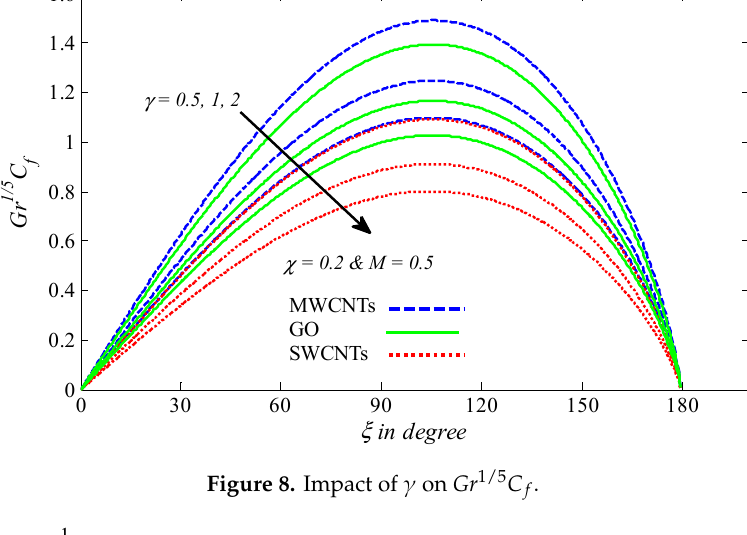
Figure 8. Impact of γ on Gr 1/5 C f .